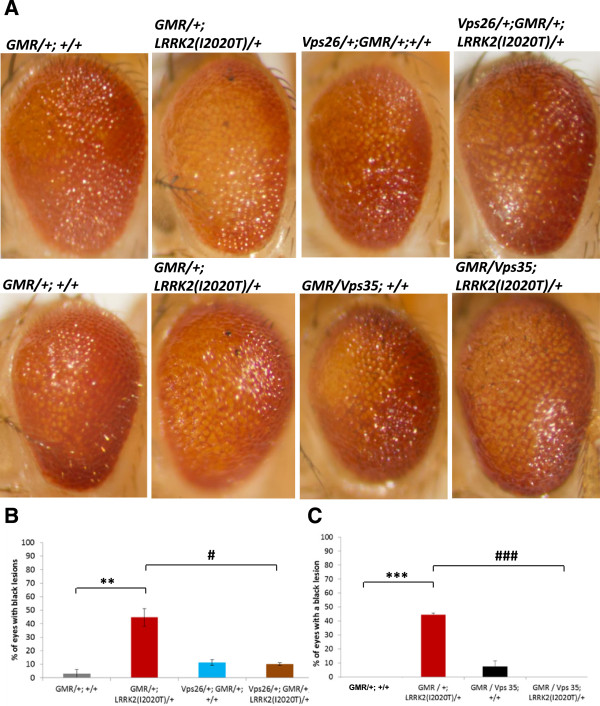
Eye-specific overexpression of Vps26 or Vps35 rescues the black lesion phenotype caused by expression of LRRK2(I2020T). A) Representative stereomicroscope images of eyes overexpressing Vps26 (upper panel) and Vps35 (lower panel). B) Quantification of black lesions in flies overexpressing Vps26. Total of 314 eyes from 2-6 independent crosses/genotype (males and females) was analyzed. C) Quantification of black lesions in flies overexpressing Vps35. Total of 312 eyes from 3 independent crosses/genotype (males and females) was analyzed. All flies were reared at 29°C. Statistical analysis by One-Way ANOVA, Bonferroni’s post-test (P‹0.0001). Statistically significant difference compared to control (GMR alone) is denoted as ** for P < 0.001, or *** for P < 0.0001. Statistically significant difference compared to GMR/+;LRRK2(I2020T)/+is denoted as # for P < 0.05, or ### for P < 0.0001.